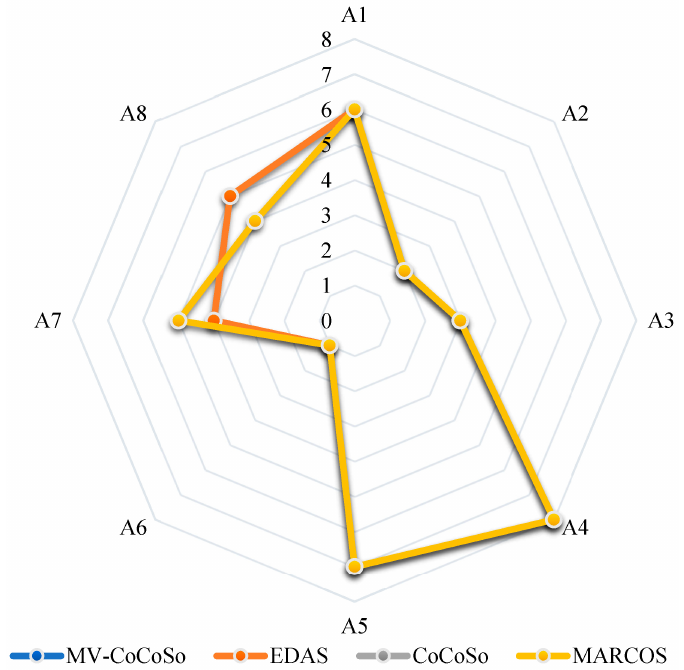
Figure 4. Comparison of four MCDM techniques’